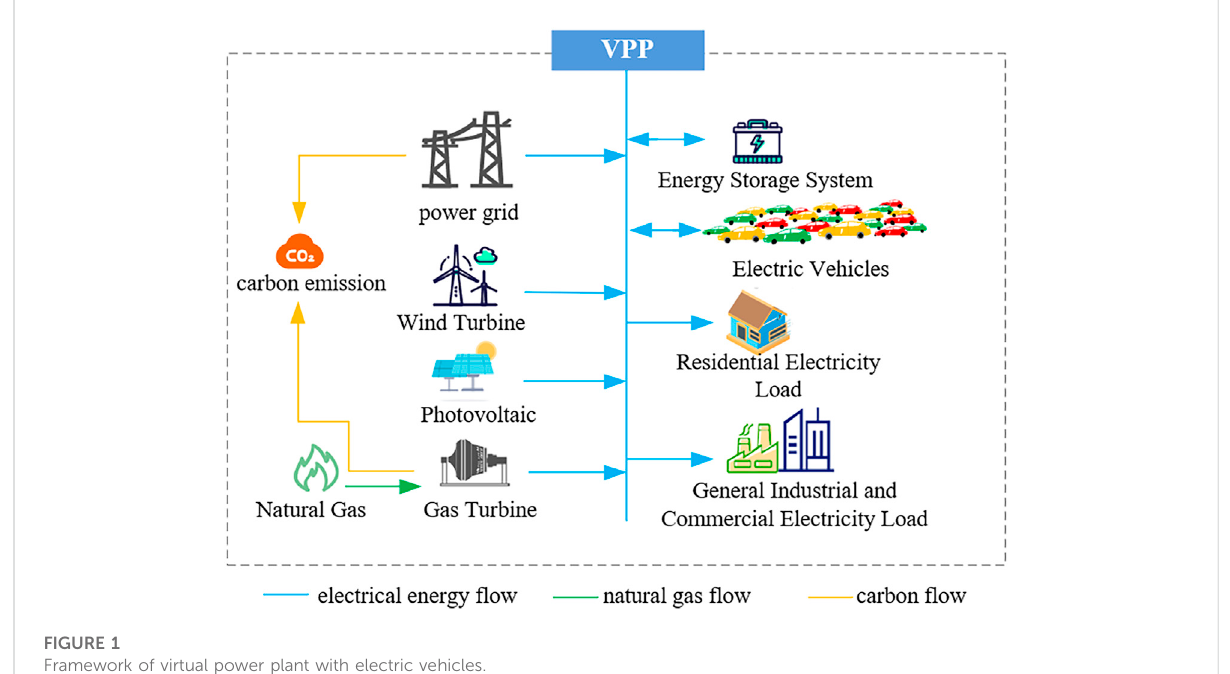
FIGURE 1 Framework of virtual power plant with electric